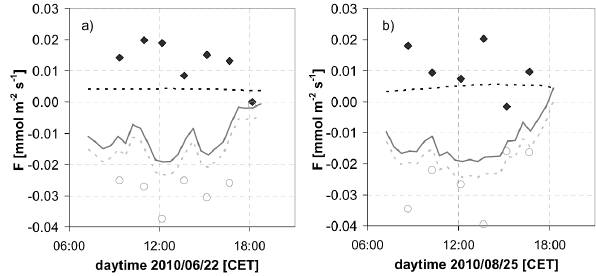
Figure 5. Comparison of NEE flux partitioning with isotopic back- ground (respiration flux F R : black diamonds, assimilation flux F A : light-grey circles) and a common FPM (dashed lines in same col- ors); the NEE measured via eddy covariance is illustrated as a dark- grey solid